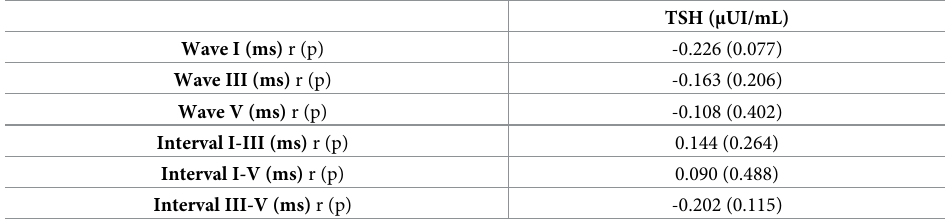
Table 3. Spearman’s correlation analysis between TSH and each ABR wave and interval.